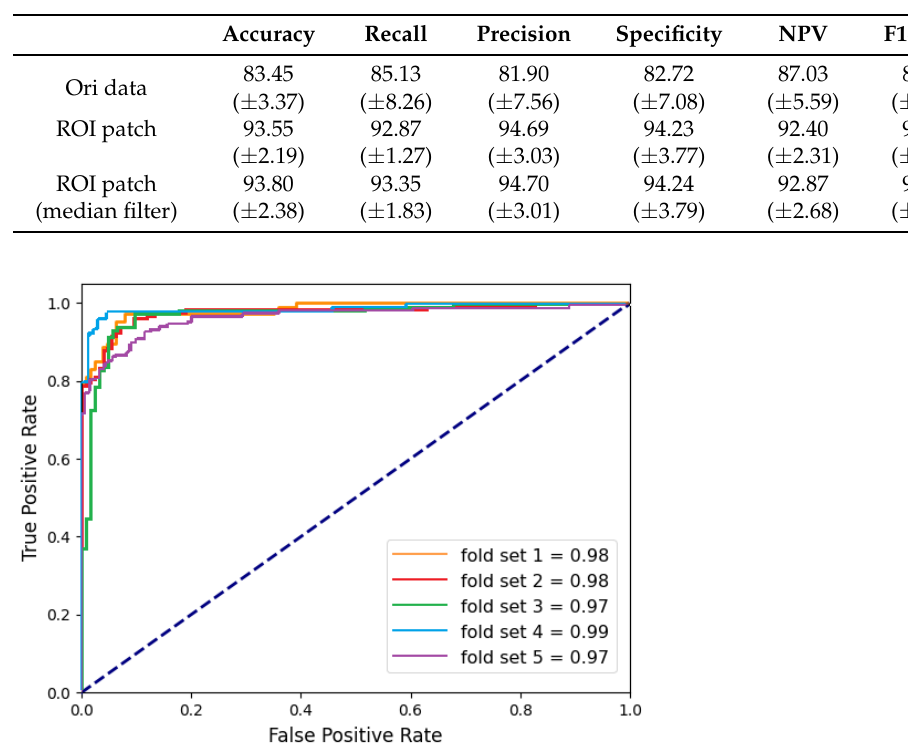
Table 2. Performance for classifying bone marrow edema from individual MR slices (%).